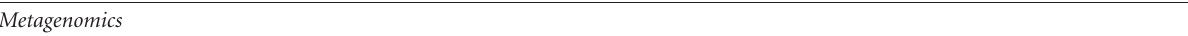
Table 3: Commonly used nucleic acid-based (culture-independent) analytical methods. PCR/denaturing electrophoretic polyacrylamide gels (PCR/DGGE,